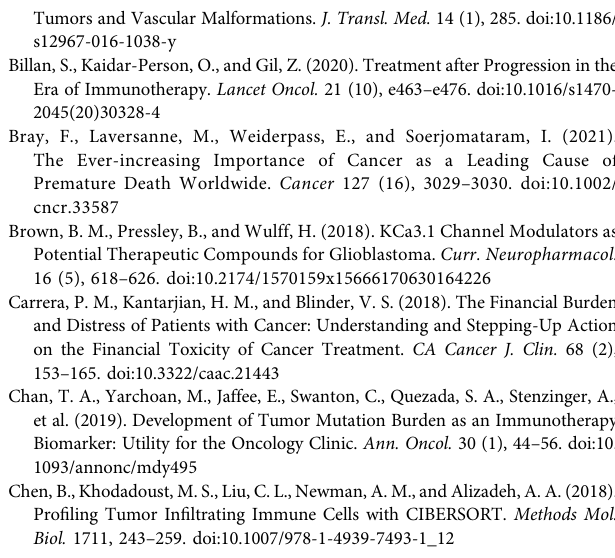
Supplementary Figure S1 | Analysis of KCNN4 expression patterns at the proteomic level between pan-cancer and non-cancerous samples using CPTAC datasets from UALCAN database. * p < 0.05, ** p < 0.01, *** p < 0.001. Supplementary Figure S2 | DNA methylation level of KCNN4 in pan-cancer datasets obtained from the UALCAN database. (A – Q) Analysis of DNA methylation level of KCNN4 between pan-cancer and non-cancerous samples. * p < 0.05, ** p < 0.01, *** p < 0.001. Supplementary Figure S3 | Biomarker analysis of KCNN4 compared to other canonicalbiomarkersignatures in immunotherapy-treated cancercohortsbased on the TIDE